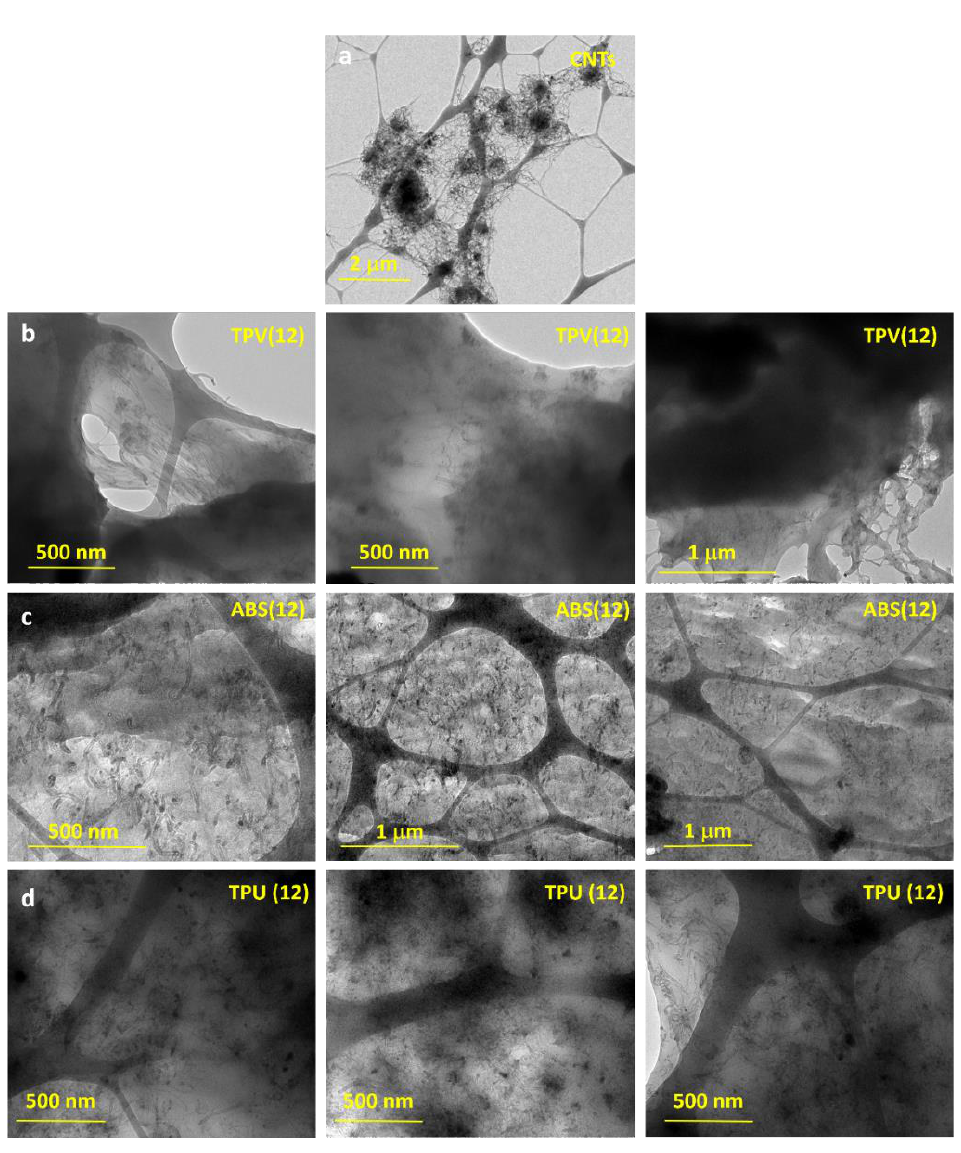
Figure 3. TEM micrographs of samples: ( a ) CNTs; ( b ) TPV(12) nanocomposite; ( c ) ABS(12) nanocomposite; ( d ) TPU(12) nanocomposite.